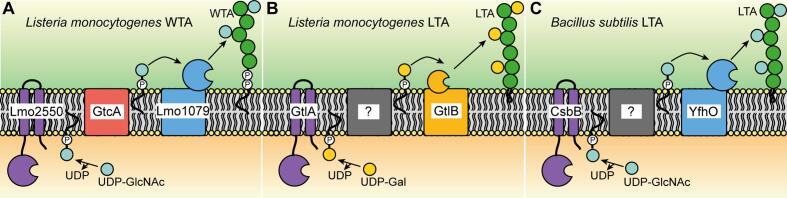
Overview over the proposed WTA and LTA glycosylation process in L. monocytogenes serovar 1/2a strains and LTA glycosylation in B. subtilis. (A) Model of the WTA glycosylation process in L. monocytogenes. The cytoplasmic glycosyltransferase (GT) Lmo2550 uses UDP-GlcNAc to form a C55-P-GlcNAc intermediate that is flipped across the membrane by the putative flippase GtcA (Eugster et al., 2011, Promadej et al., 1999, Cheng et al., 2008). Lmo1079 (YfhO), then transfers the GlcNAc residue onto the WTA backbone on the outside of the cell (Eugster et al., 2015). (B) Model of the LTA glycosylation process in L. monocytogenes. GtlA, the putative cytoplasmic GT, forms a C55-P-galactose intermediate (Percy et al., 2016) that is transported across the membrane by an unknown flippase enzyme. The galactose residue is then transferred onto the LTA backbone by the likely GT enzyme GtlB (Rismondo et al., 2018). (C) Model of the LTA glycosylation process in B. subtilis. The cytoplasmic GT CsbB transfers GlcNAc residues to the C55-P lipid carrier (Rismondo et al., 2018). The C55-P-GlcNAc intermediate is subsequently transported across the membrane by an unknown flippase and the GlcNAc residue is transferred onto the LTA backbone by YfhO on the outside of the cell (Rismondo et al., 2018).